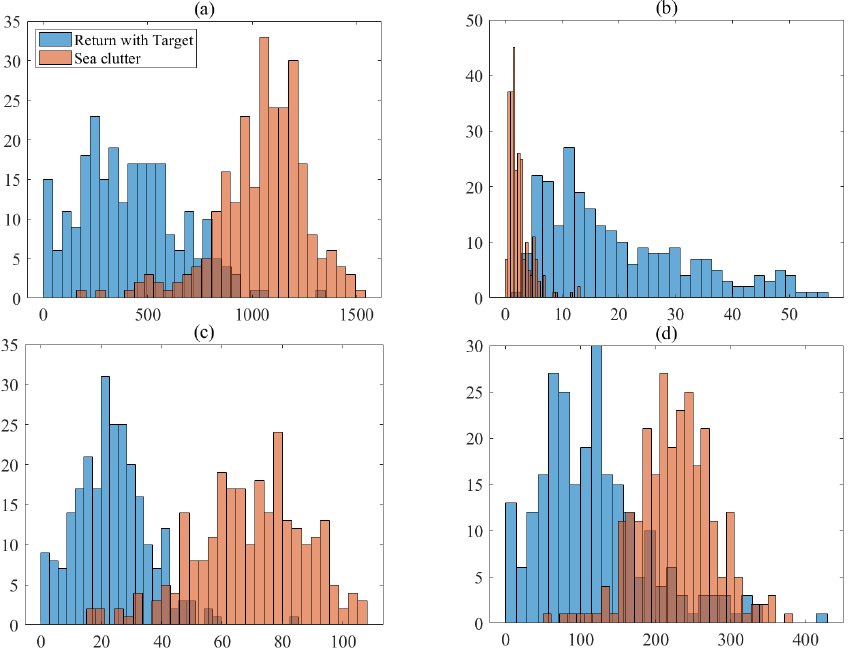
Figure 3. Histogram contrasts of the four features of sea clutter and target returns of #54 data at the HH polarization. ( a ) ξ 1 . ( b ) ξ 2 . ( c ) ξ 3 . ( d ) ξ 4 .